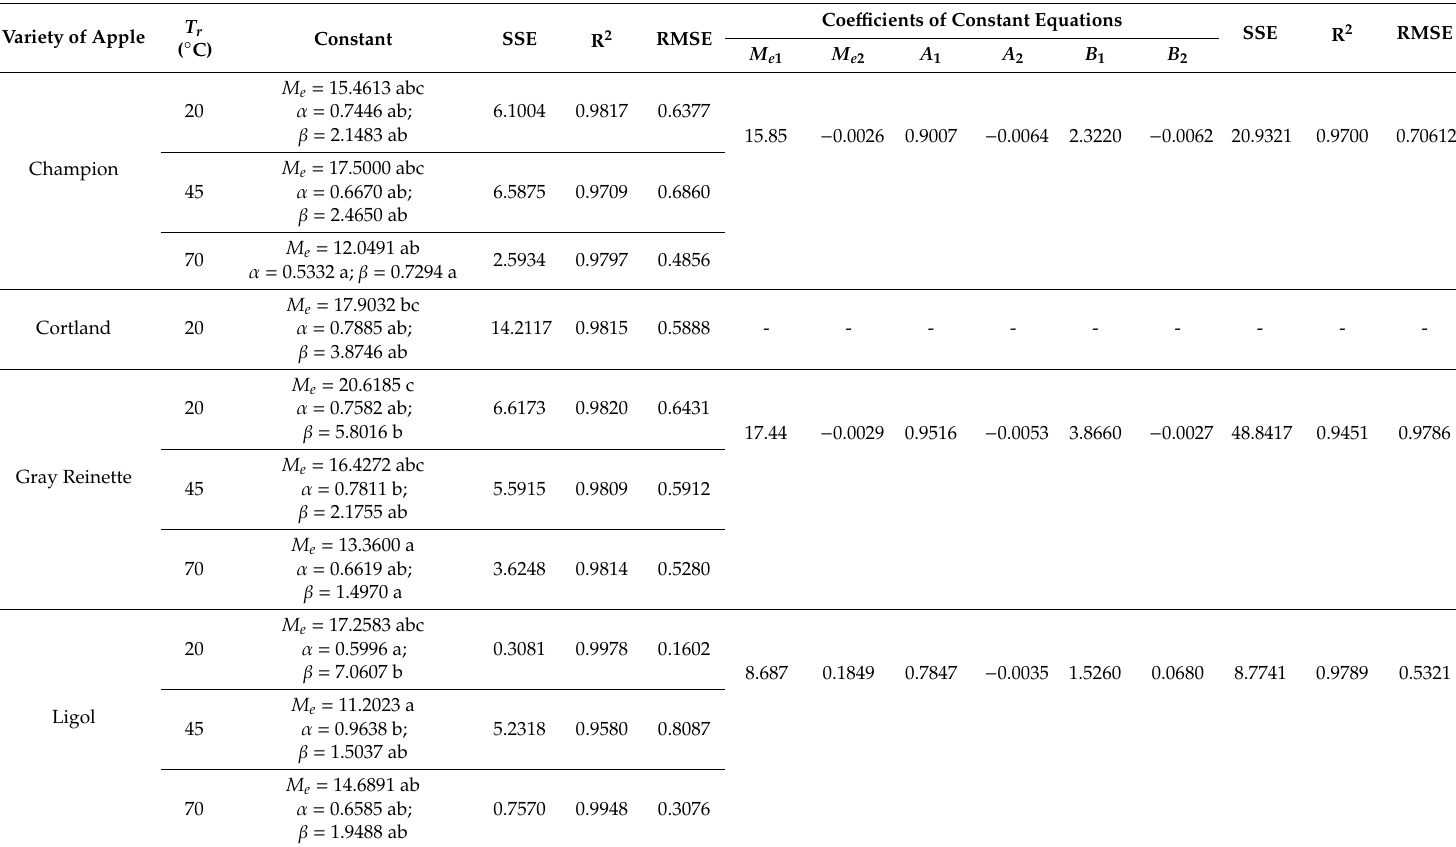
Table 6. Coe ffi cients of the constant equations for the Weibull model (Equation (3)) and results of statistical analyses on the rehydration modeling of di ff erent varieties of dried